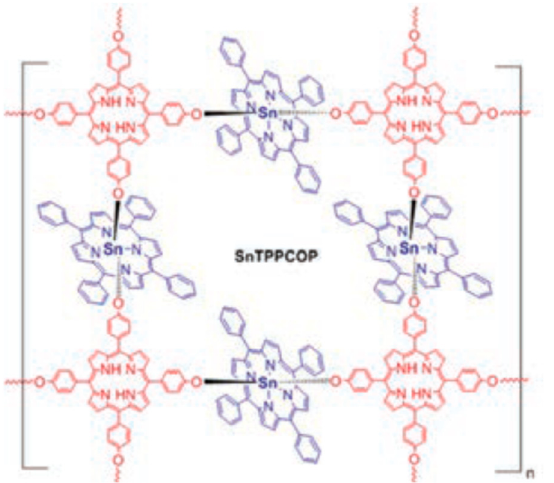
Figure 18. Tin porphyrin axially-coordinated 2D covalent organic polymer (SnTPPCOP) for HER activity (Wang Q. et al., 2022) [179]. Table 4. Activation of small molecules for sustainable